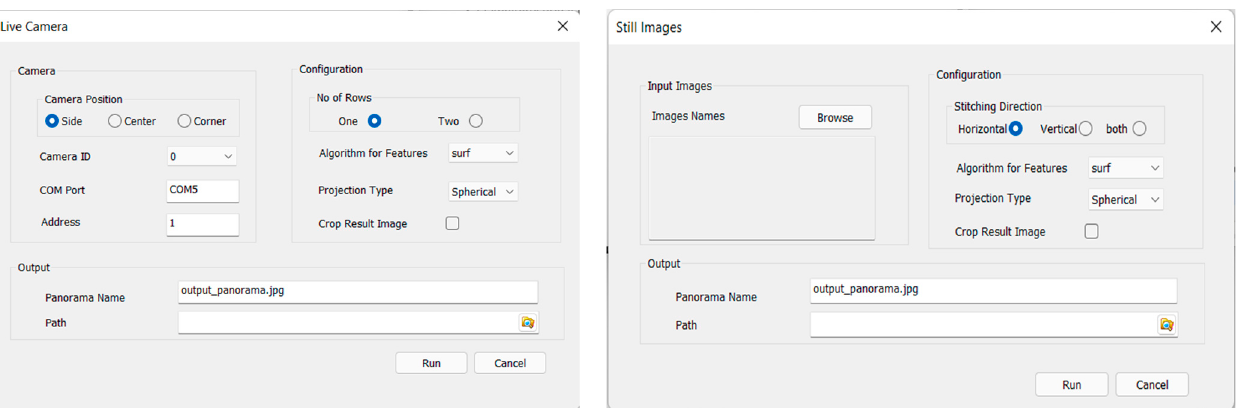
Figure 9. Panoramas from center: upper (10,400 × 1600 = 360° × 56°) and lower (10,400 × 1000 = 360° × 36°). Figure 10. Panoramas from side: left (5800 × 1600 = 180° × 56°) and right (5800 × 1000 = 180° × 36°).